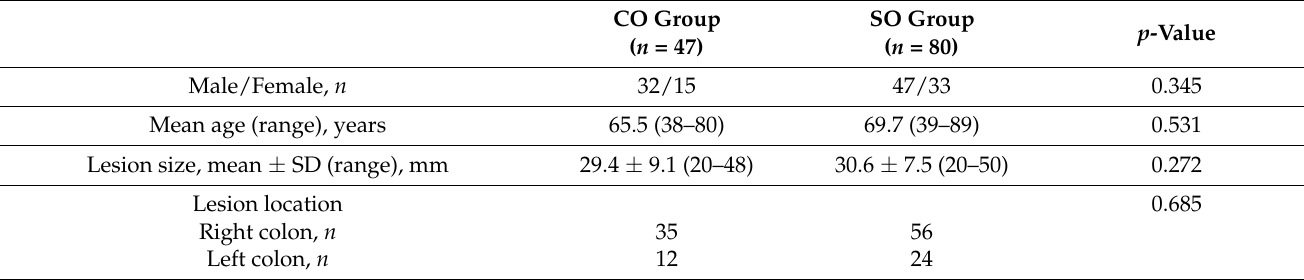
Table 1. Patient demographics and clinicopathologic features.